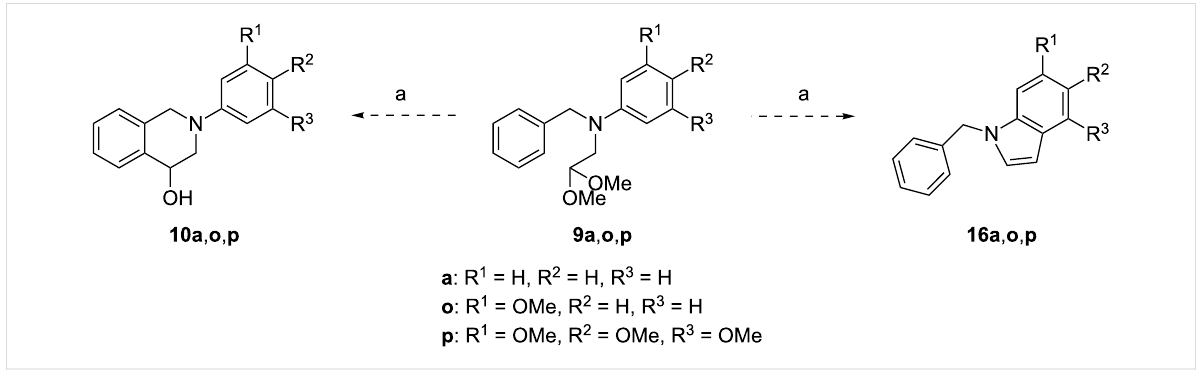
Scheme 6: Competition between the formation of THIQs 10a , o , p and indoles 16a , o , p . Conditions: (a) 70% HClO 4 , rt.